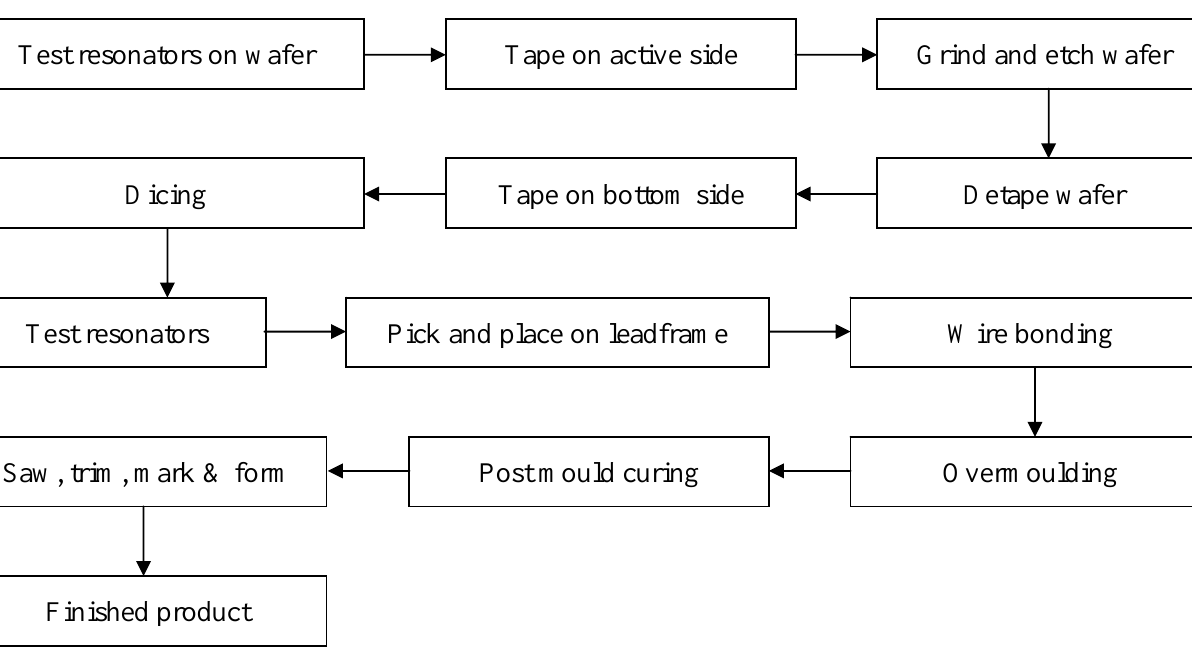
Figure 2. Production flow for plastic encapsulation of a plastic overmoulded